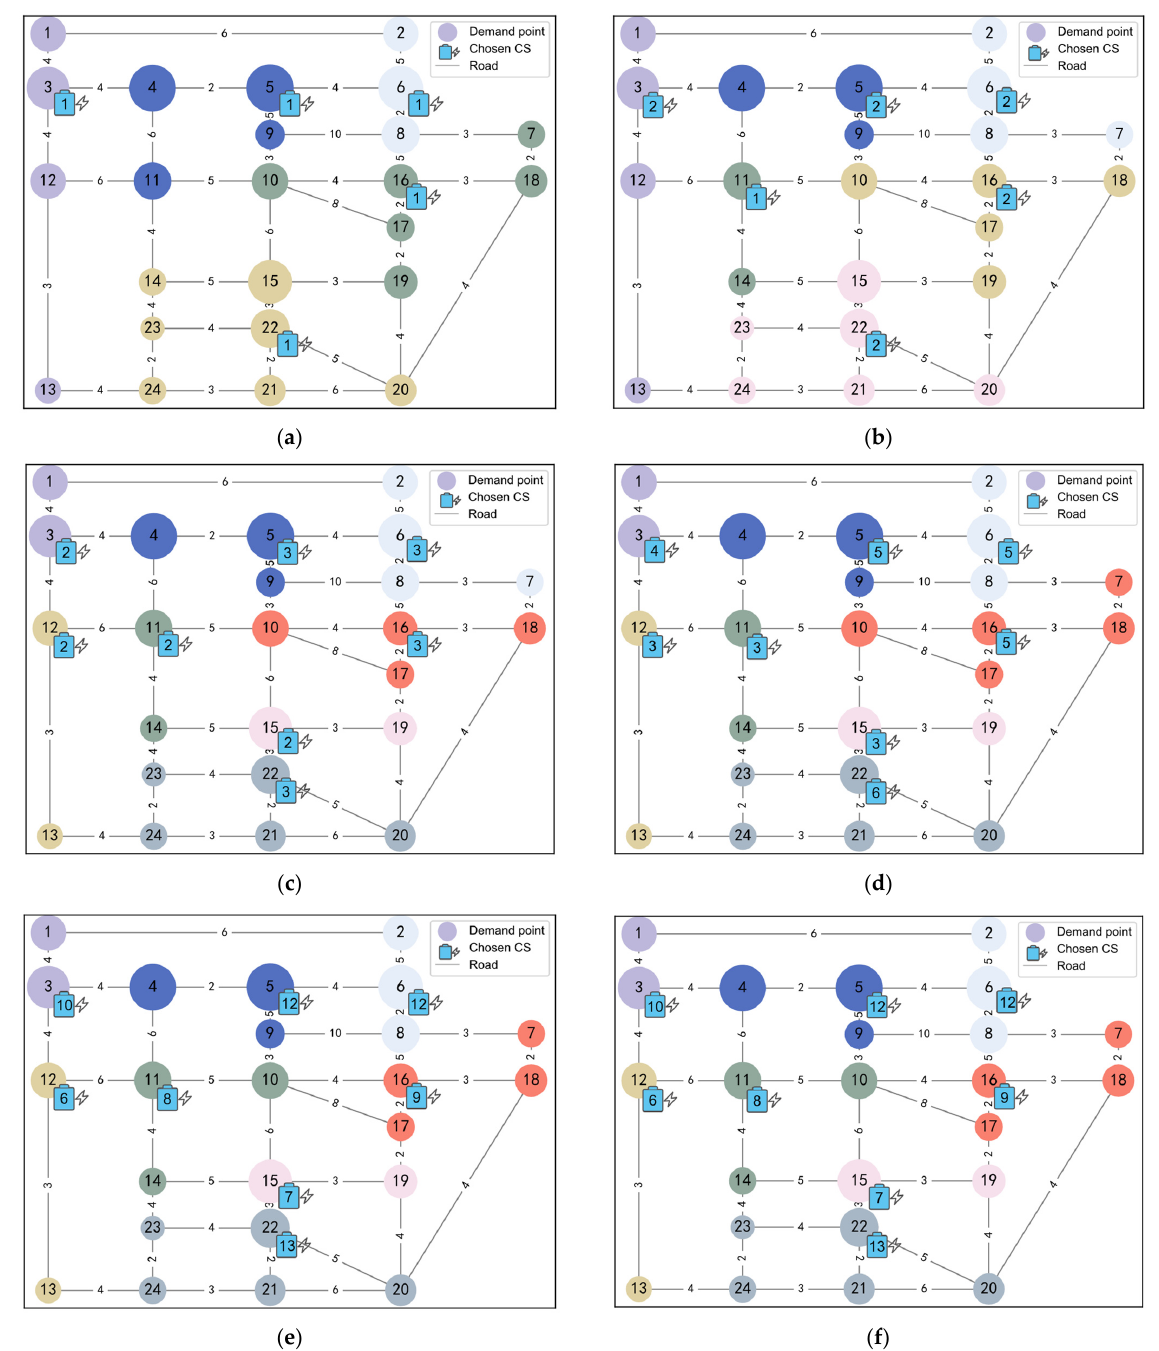
Figure 5. The locations of optimal CSs at different stages based on the Sioux Falls road network. The chosen CSs at each stage are labeled by the number of FCPs in them. The size of each circular node represents the relative amount of EV charging demand at each demand point in a day. EVs at the demand points with the same color will go to the CS in the corresponding color area for charging. ( a ) Stage 1; ( b ) Stage 2; ( c ) Stage 3; ( d ) Stage 4; ( e ) Stage 5; ( f ) layout optimization results with a one-time strategy.